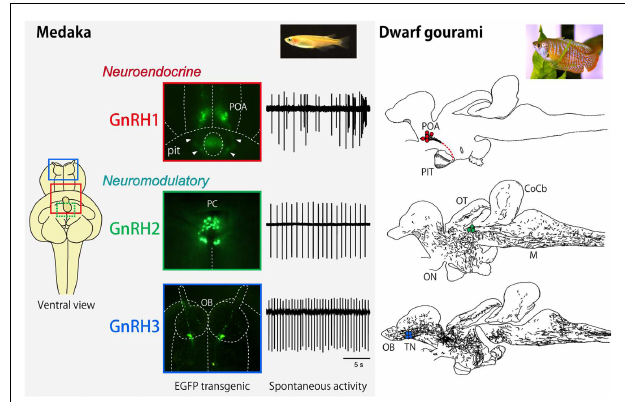
FIGURE 1 | Neuroanatomical and electrophysiological characteristics of GnRH1, GnRH2, and GnRH3 systems in medaka and dwarf gourami . The inset for the left column indicates the ventral view of the GFP-transgenic medaka brain, showing the localization of GnRH1 (red), GnRH2 (green), and GnRH3 (blue) neurons.The GFP-labeled GnRH neurons and typical traces for their spontaneous electrical activities are shown for medaka.The right column illustrates the distribution of GnRH1 ∼ 3 immunoreactive cell bodies (colored dots) and fibers in sagittal brain sections.T, telencephalon; PIT, pituitary, CoCb, corpus cerebellum; ON, optic nerve; OT, optic tectum; M, medulla.The same abbreviations apply to Figure 5 .